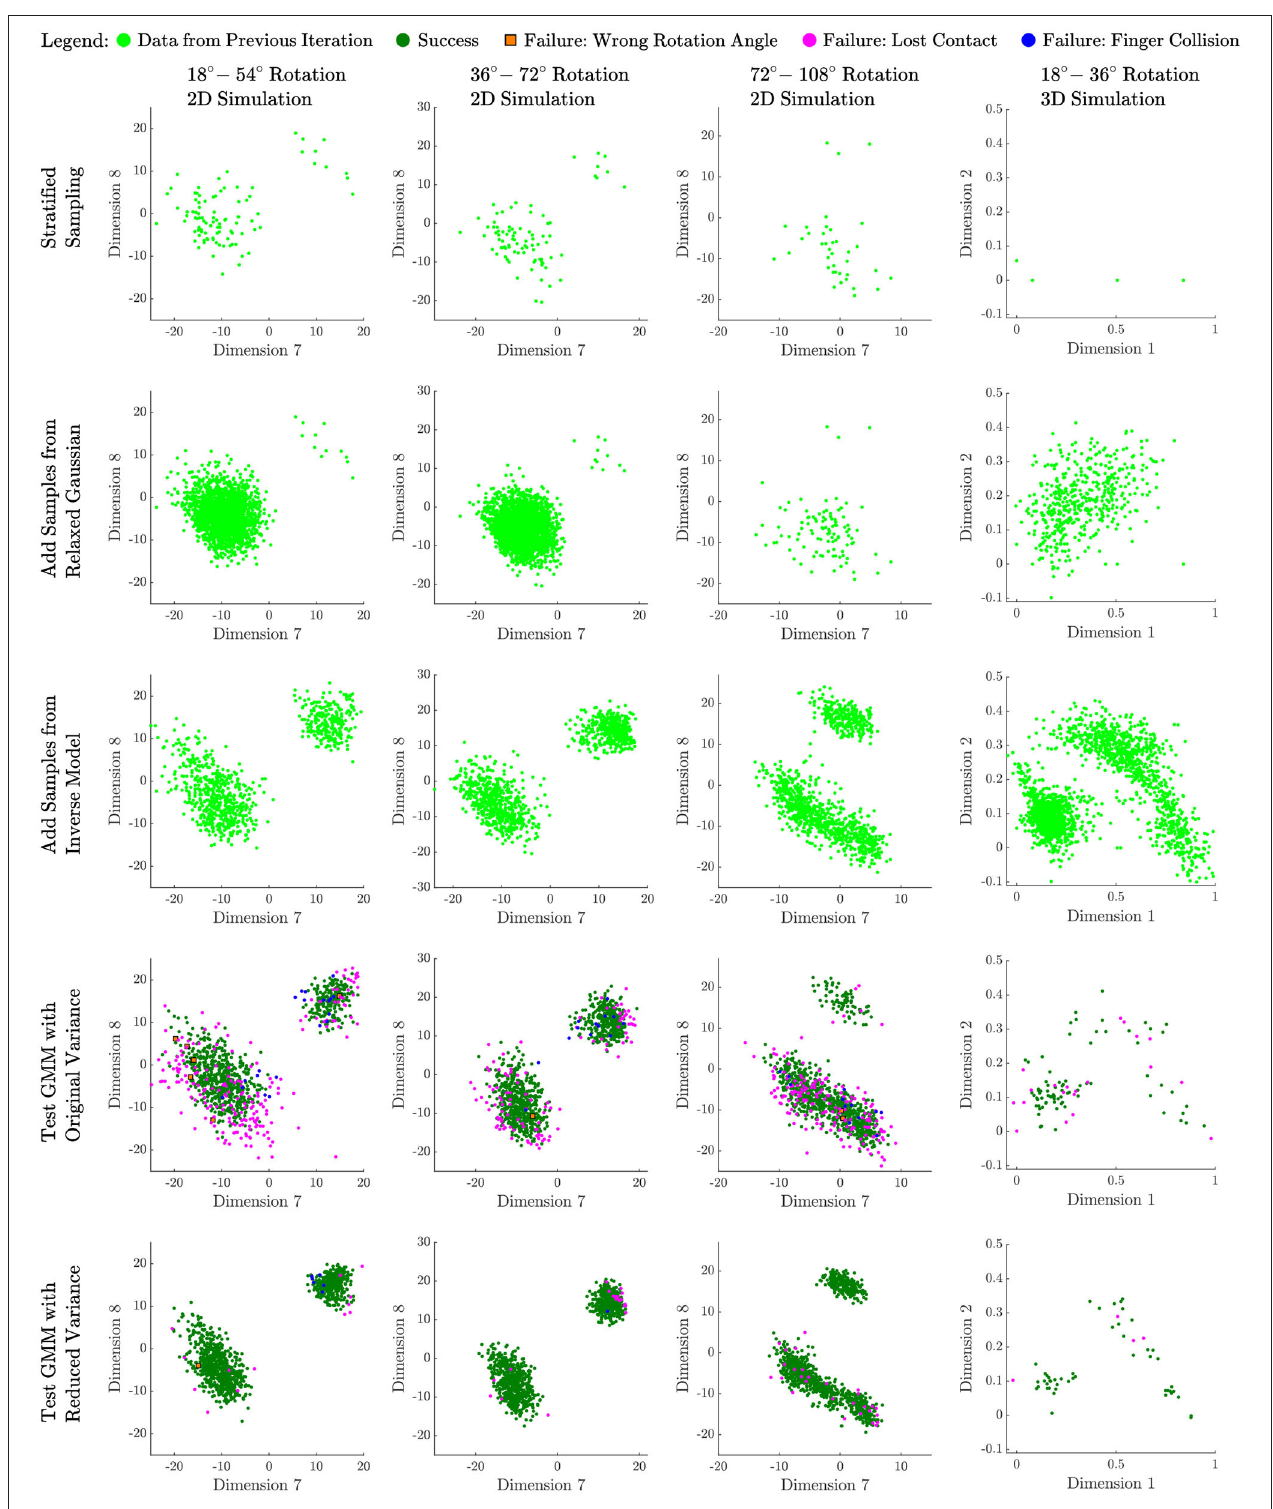
FIGURE 3 | Successful experiments from left to right: Data evolution for our best models using a 2D simulation with angle rotation ranges of 18–54, 36–72, and 72–108 degrees, and a 3D simulation with angle rotation range of 18–36 degrees.